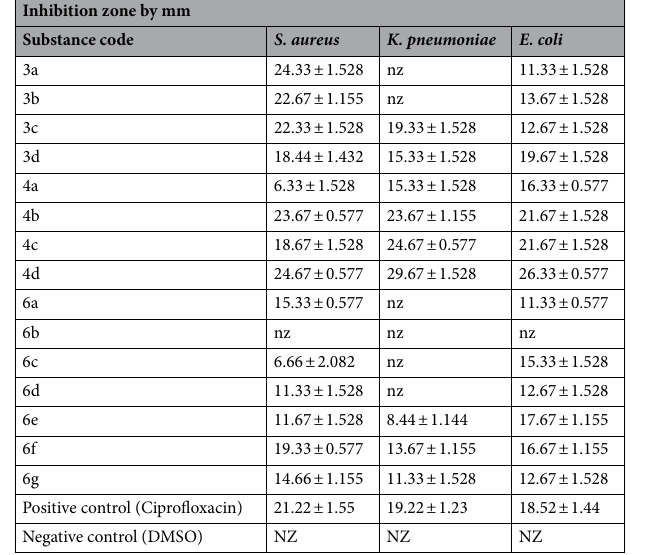
Table 3. Antibacterial activity of the tested chemical substances. Inhibition zones are be expressed as the mean ± SD (mm). S. aureus : Staphylococcus aureus , K. pneumoniae : Klebsiella pneumoniae and E. coli : Escherichia coli . Nz: no zone.